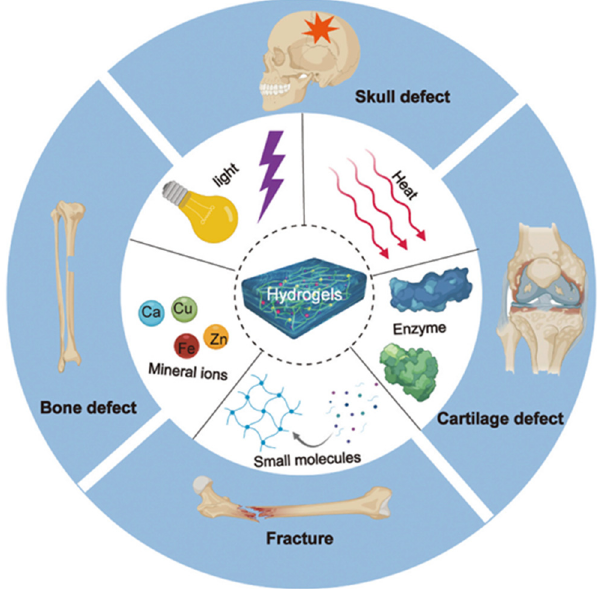
Figure 1. Diverse bionic hydrogels prepared by various activated environments (e.g., temperature (heat), light, mineral ions, small bioactive molecules, enzymes, etc.) for bone tissue regeneration. Reproduced from [4].